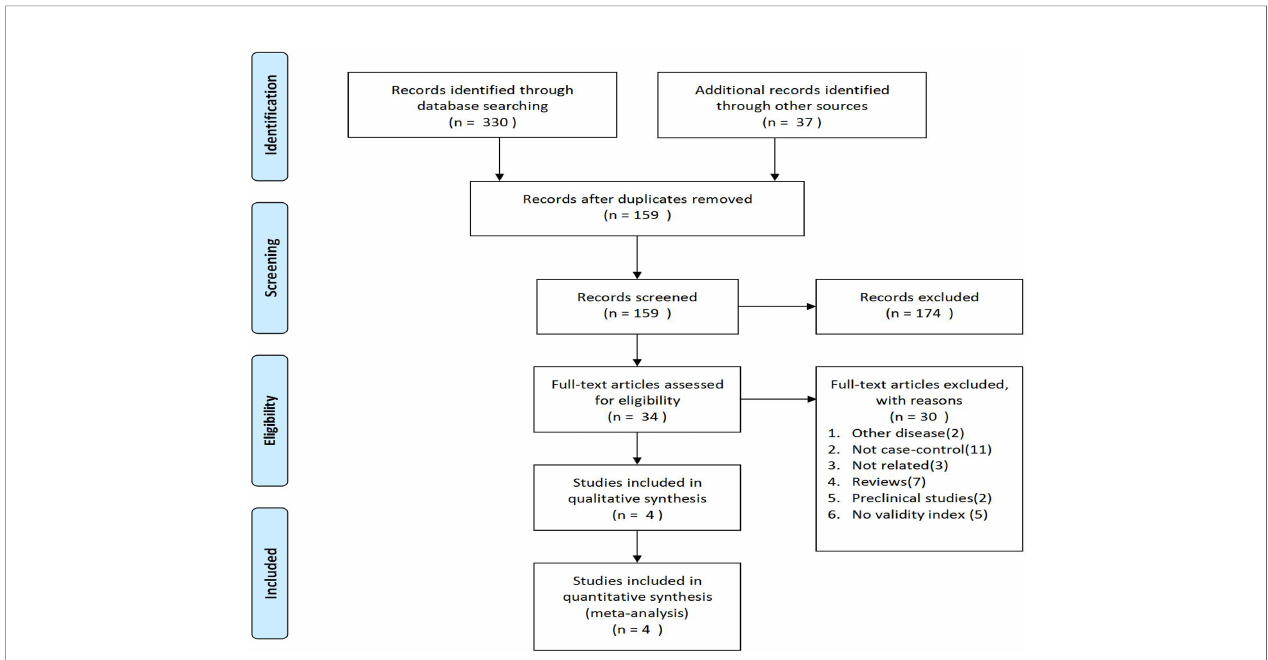
FIGURE 1 | Flowchart of studies evaluating quali fi ed research through selection